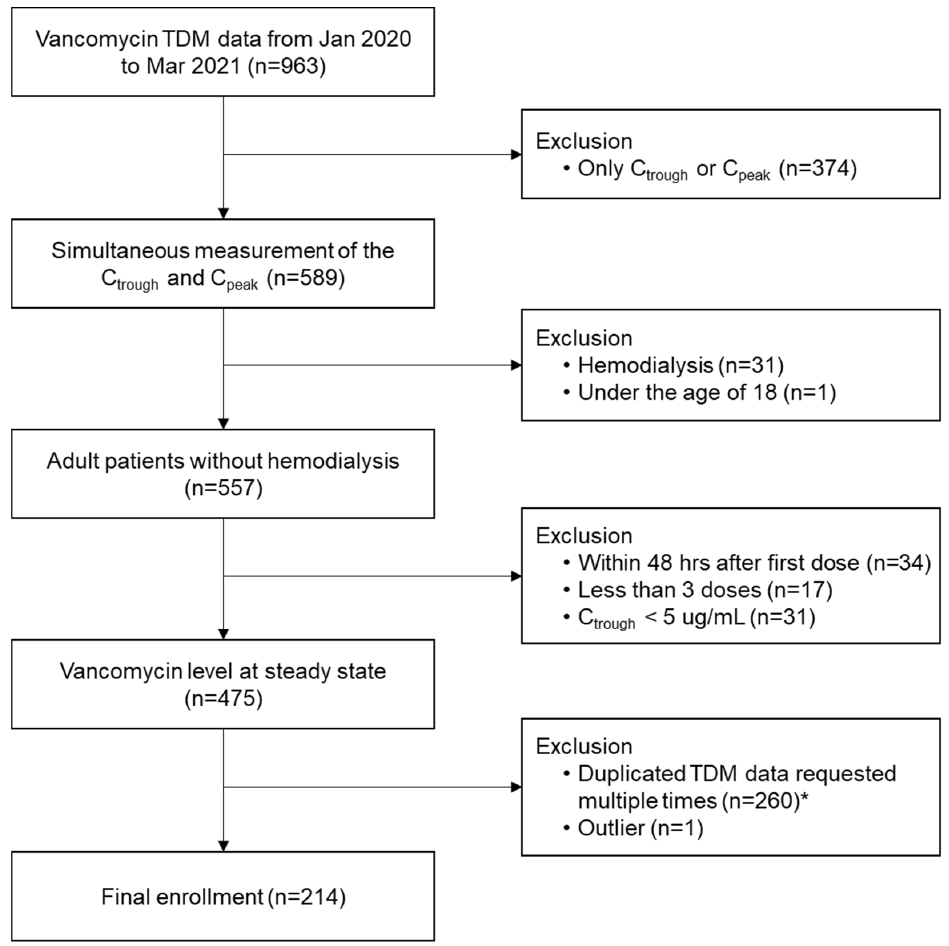
Figure 1. Schematic diagram of the data collection process. * In cases where TDM was requested multiple times for the same patient, the first set of data was selected. Abbreviations: C trough , trough concentration of vancomycin; C peak , peak concentration of vancomycin; and TDM, therapeutic drug monitoring.